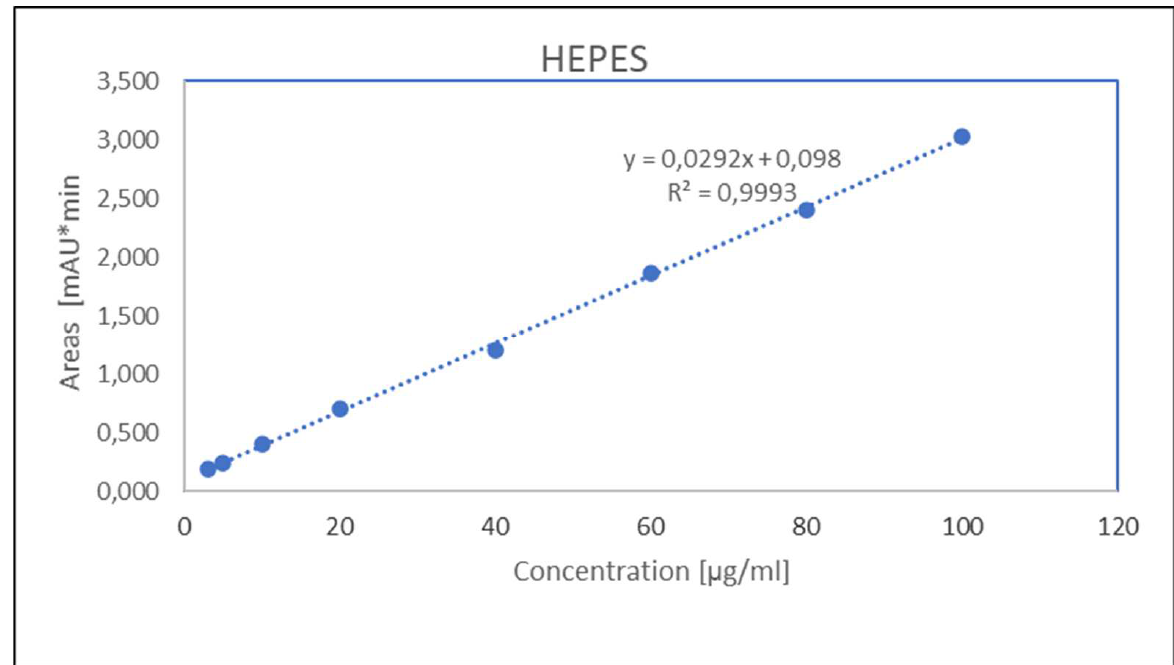
Table 1. Effect of different solvents on HEPES retention time.